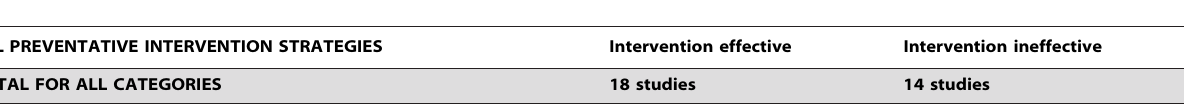
ALL PREVENTATIVE INTERVENTION